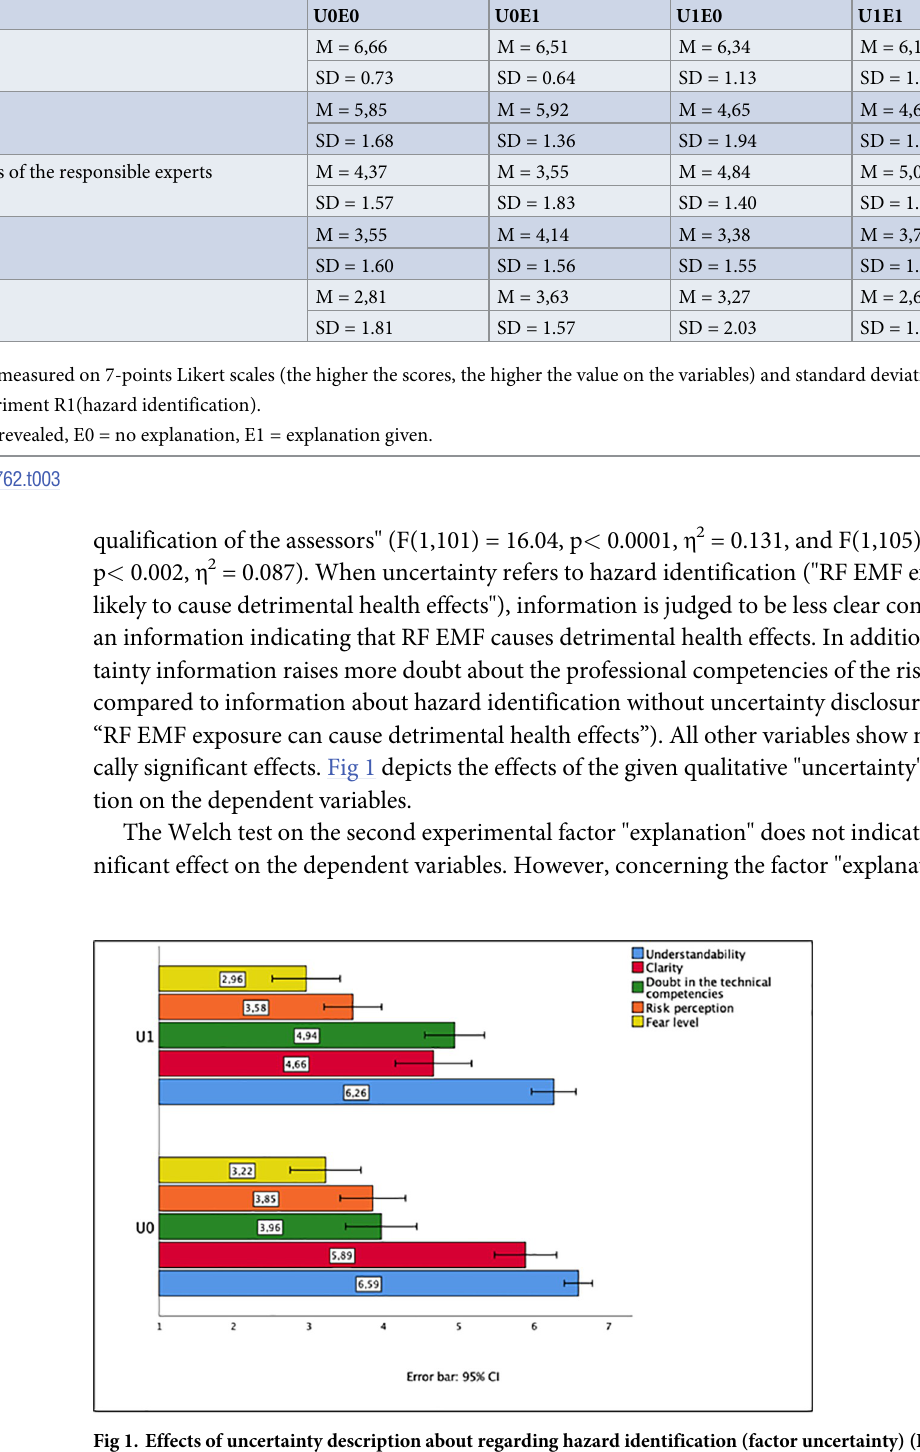
Table 3. Effects of uncertainty information regarding hazard identification (R1).